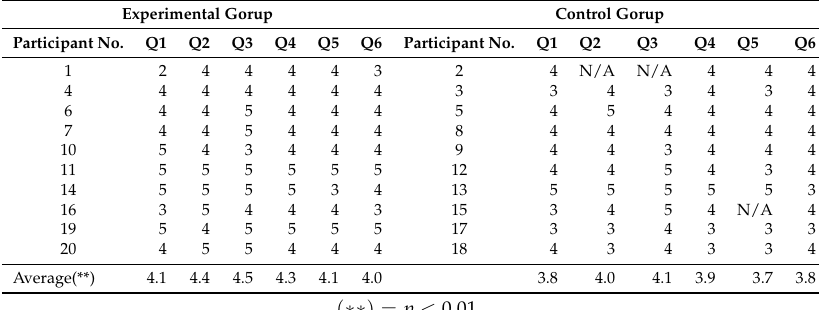
Table 4. Results of post-survey of questions 1–6.